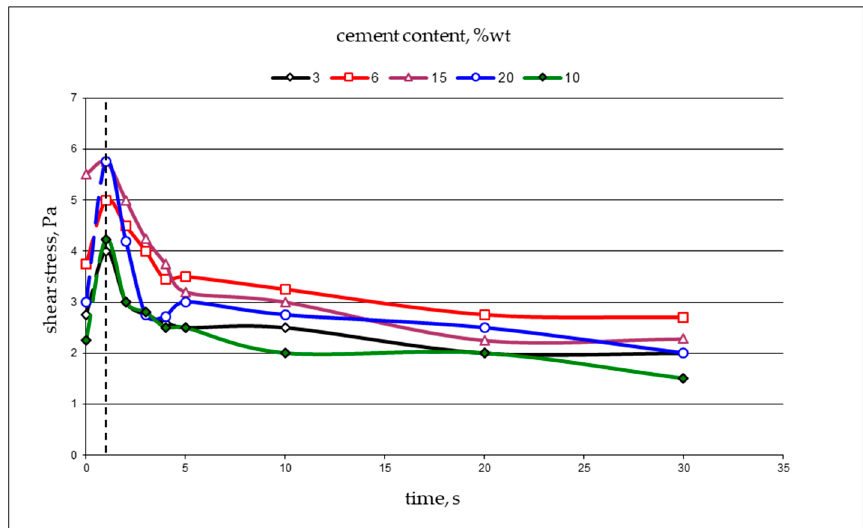
Figure 7. Stiffness of the pseudo-thixotropic structure of slurries with different cement